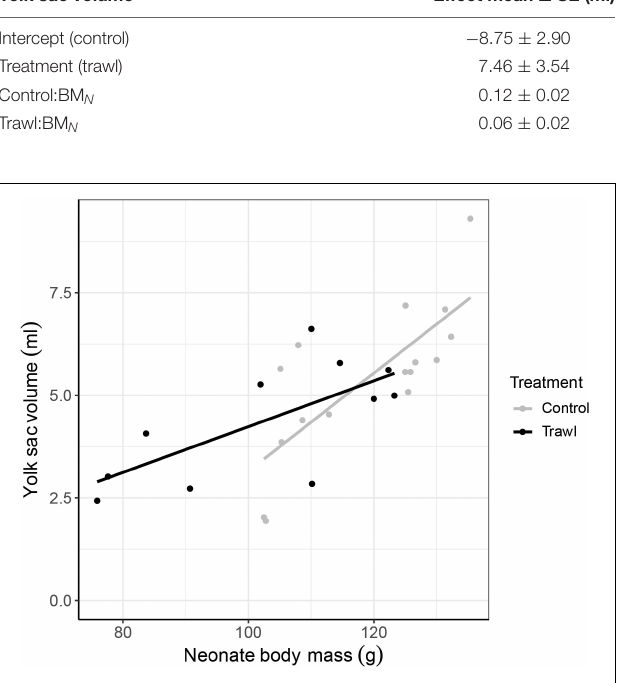
FIGURE 3 | Relationship between neonate yolk sac volume (ml) and neonate body mass (g) at birth (day 0). Data are plotted separately for each maternal Treatment: Control (gray; n = 16) and Trawl (black; n = 11). Points represent original data, and lines represent the linear regressions fitted to the data.